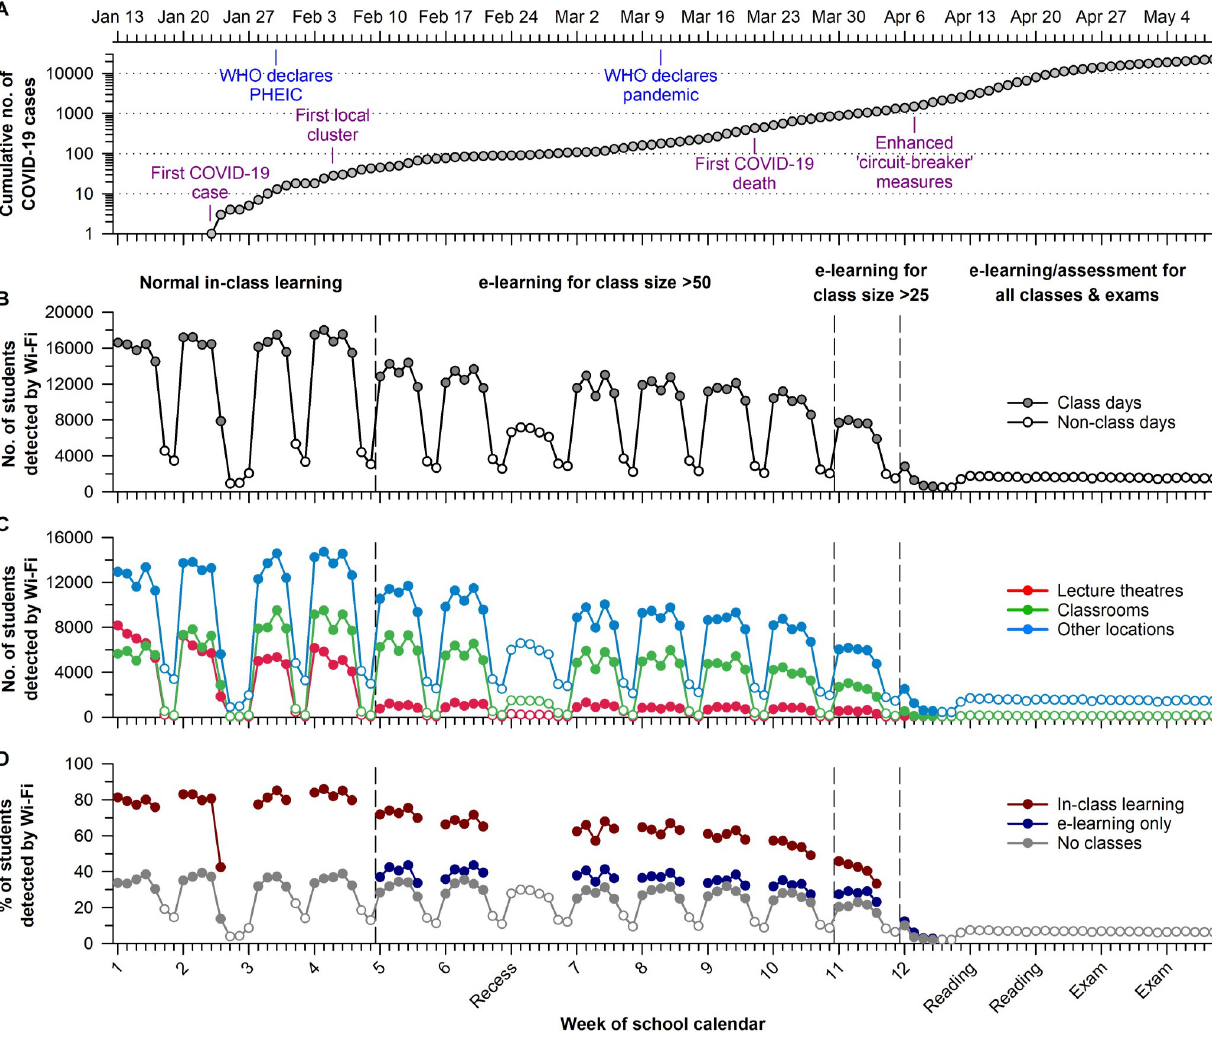
Fig 1. E-learning interventions decreased the number of students detected on campus during the COVID-19 outbreak. ( A ) The timeline of COVID-19 cases and events in Singapore is shown for the second semester of the 2019/20 school year at the National University of Singapore (NUS). Each e-learning intervention was associated with a decrease in the daily number of students who connected to the NUS Wi-Fi network, assessed ( B ) campus-wide and ( C ) for different types of locations on campus. ( D ) The daily percentage of students detected by Wi-Fi was about two-fold greater in students with at least one class conducted by in-class learning, as compared with students with e-learning only or no scheduled class. In panels C and D , open circles indicate non- class days. COVID-19, Coronavirus Disease 2019; WHO, World Health Organisation; PHEIC, Public Health Emergency of International